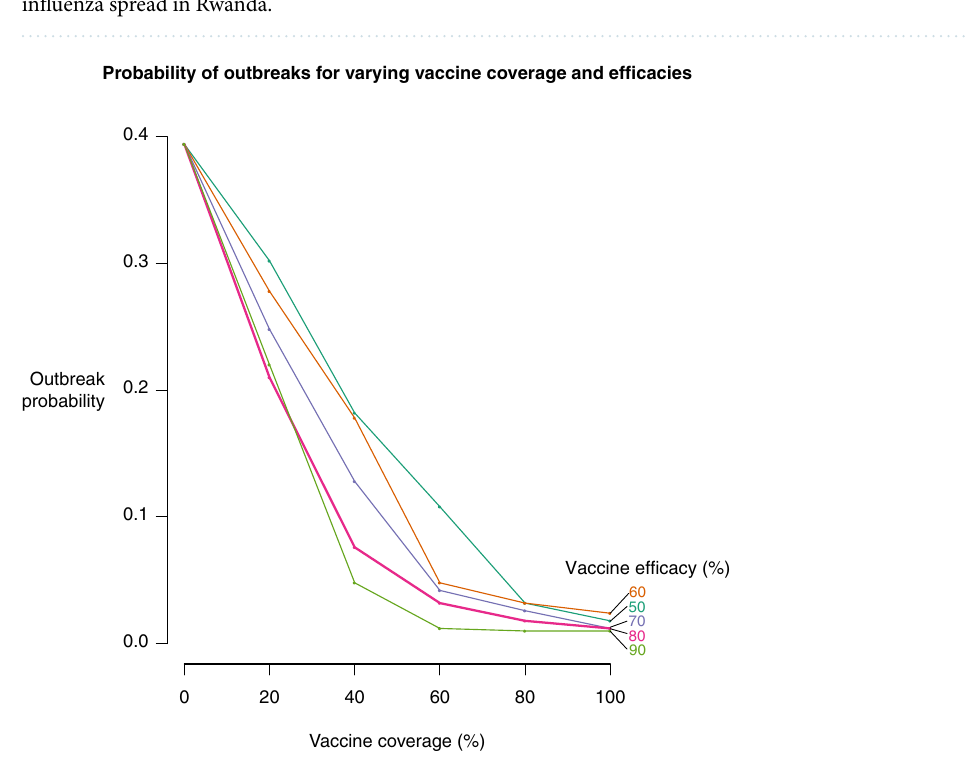
Figure 6. Comparison between observed and simulated outbreak spreads across Rwanda. Left: Map showing the location of influenza surveillance sites 11 and the cities documented to have confirmed pH1N1 influenza clusters (map made with QGIS 3.6). Right: Comparison between the observed and simulated order of pandemic influenza spread in Rwanda.